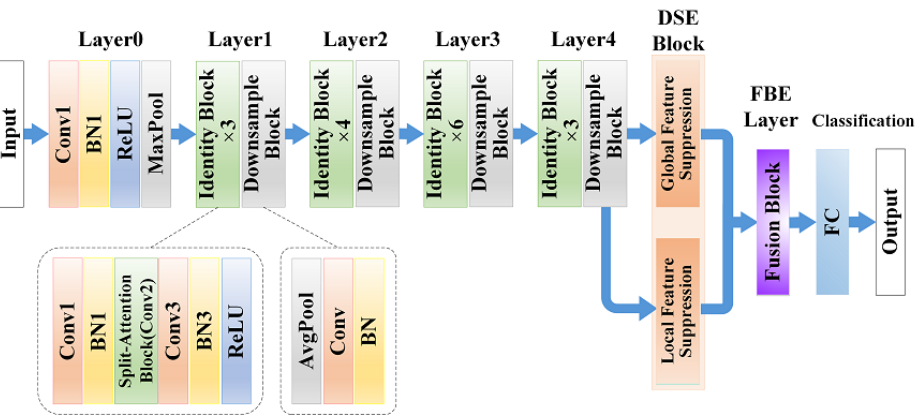
Figure 2. Architecture of the proposed